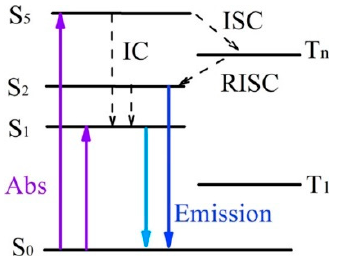
Figure 9. Exciton evolution route. Schematic potential key photophysical processes proposed for anti-Kasha photoemission of 42 . Abs, IC, ISC and RISC represent the absorption, IC, ISC and reverse ISC, respectively. The absorption and emission processes are represented as solid arrow lines. The nonradiative processes are indicated as dashed arrow lines. Reprinted with permission from [53], Copyright 2019, American Chemical Society.